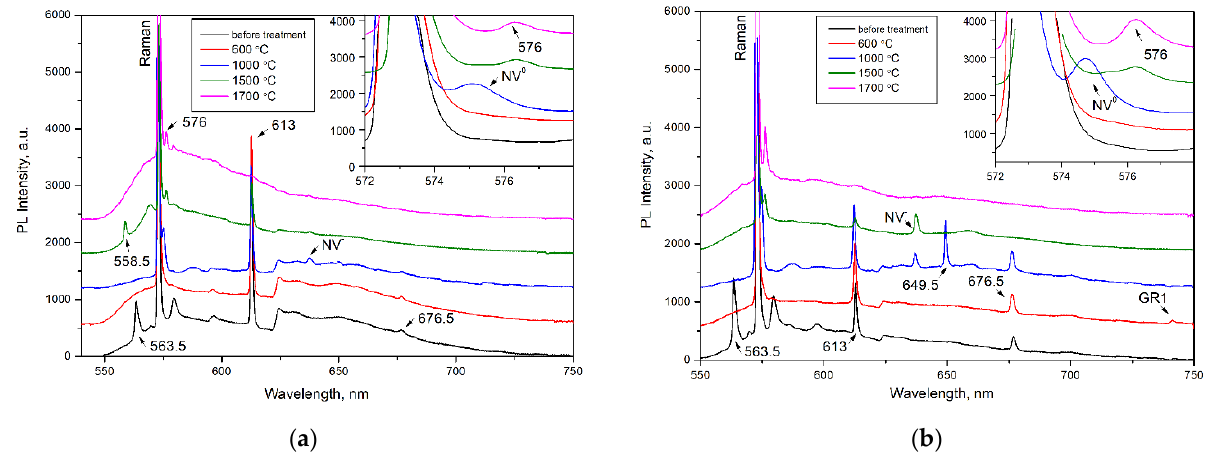
Figure 5. PL spectra (λ ex = 532 nm) of the ( a ) AO1666 and ( b ) AO1894 diamonds. Insets show the changes in the 575 and 576 nm PL systems. The spectra were shifted for clarity.